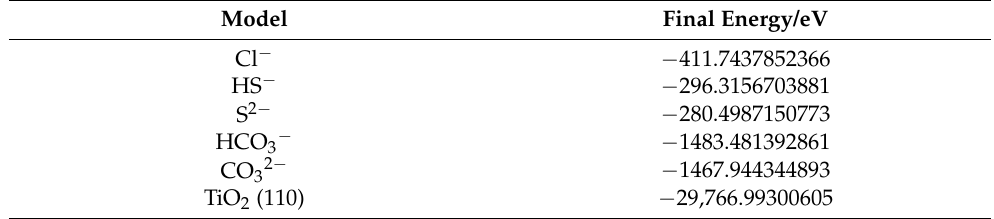
Table 4. Final energy of each corrosive species and TiO 2 (110) model after geometric optimization.